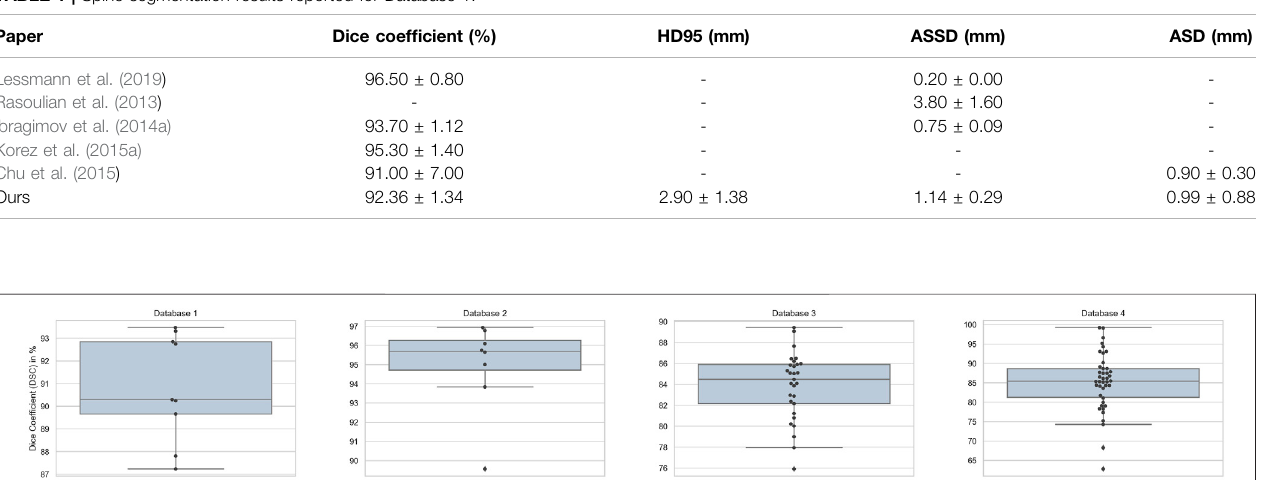
TABLE 1 | Spine segmentation results reported for Database 1.